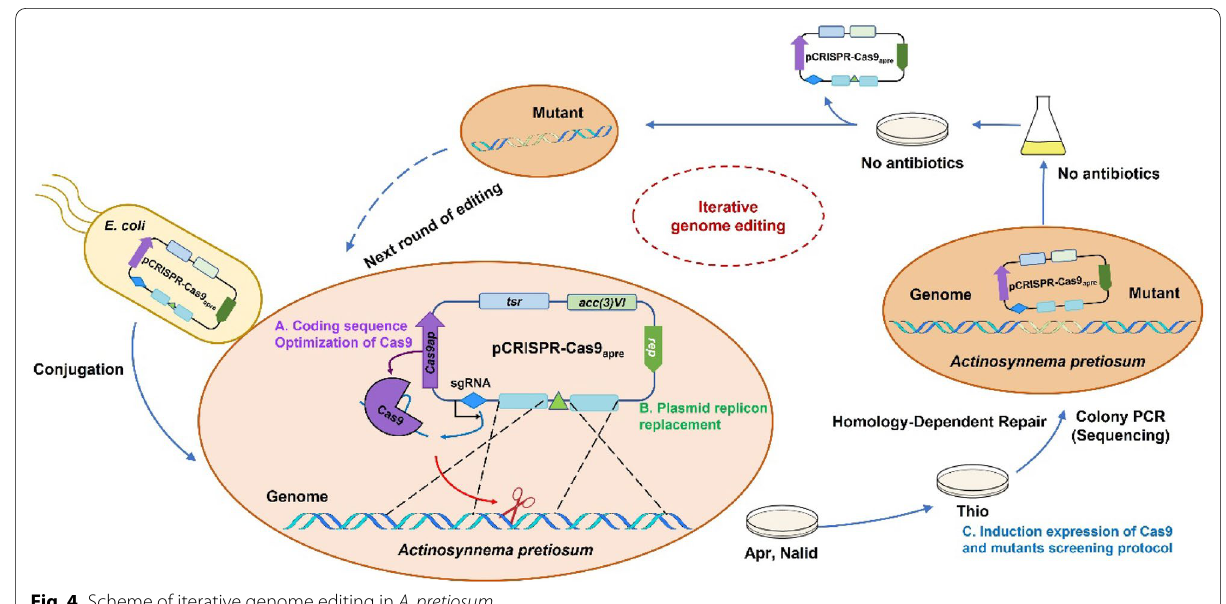
Fig. 4 Scheme of iterative genome editing in A. pretiosum